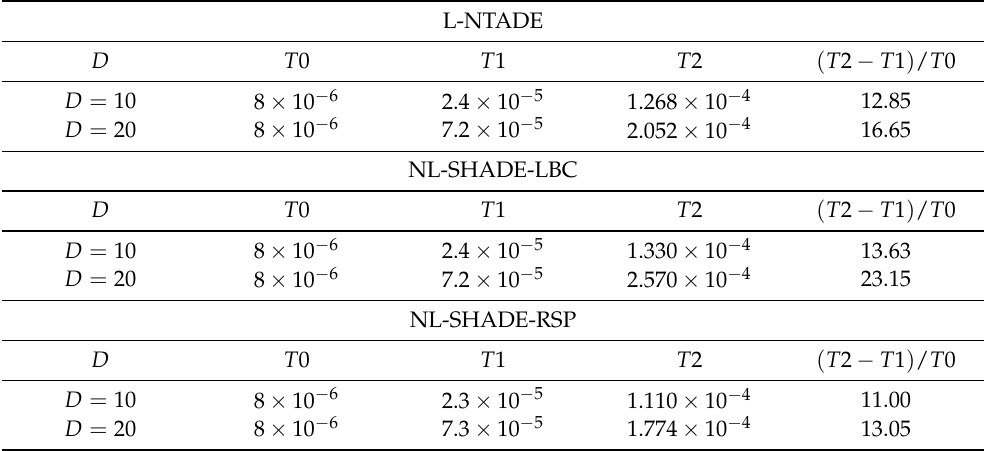
Table 6. Computational complexity of L-NTADE compared with NL-SHADE-LBC and NL-SHADE- RSP on CEC 2022